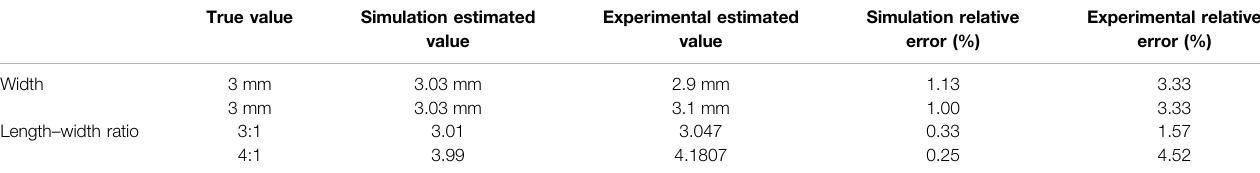
TABLE 4 | Comparison between experimental results and simulation